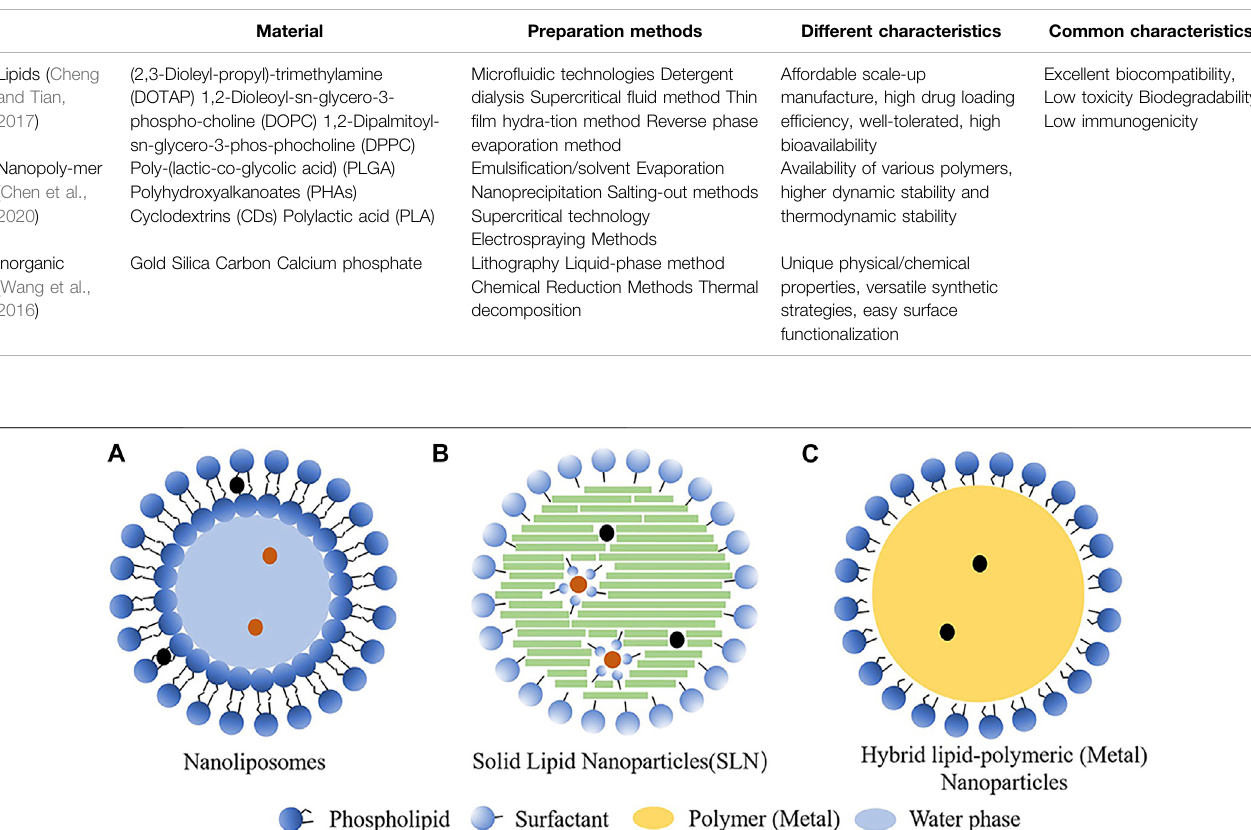
Frontiers in Nanotechnology |